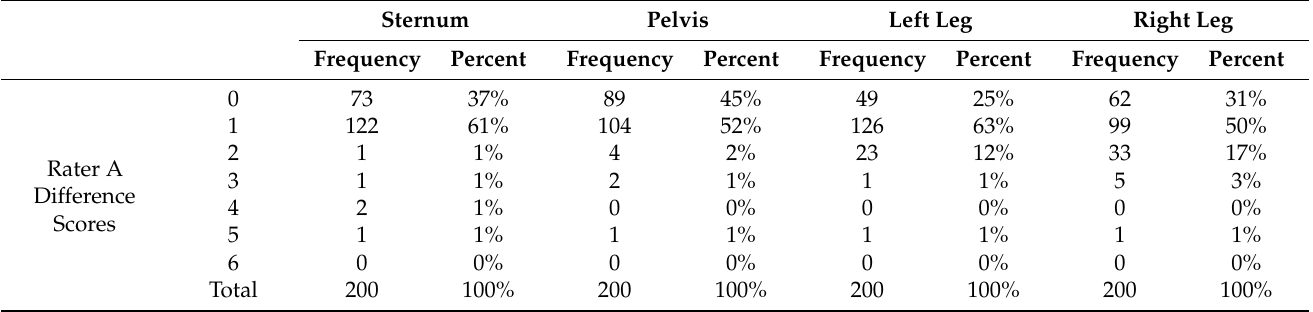
Table 3. Results of Human Raters as compared to DOTs (by Difference Score for each body